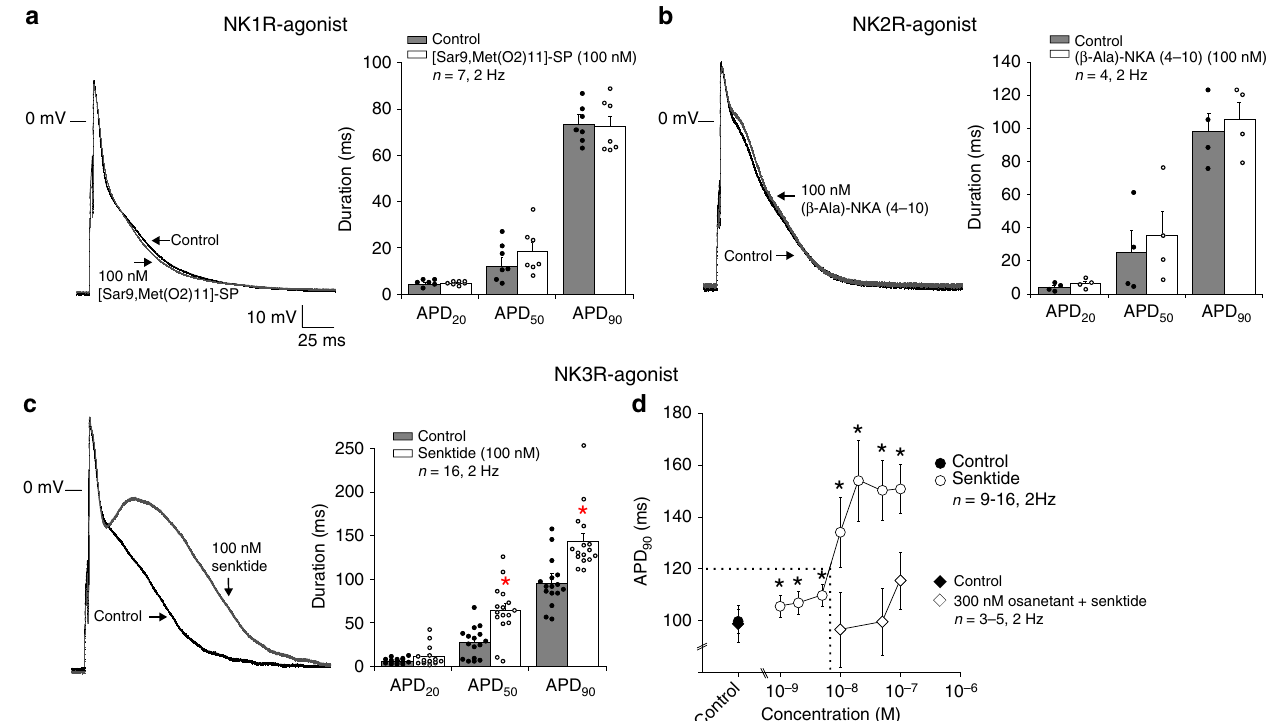
Fig. 4 Effects of different selective neurokinin receptor agonists on action potential duration. a APs elicited at 2 Hz from an atrial cardiomyocyte under control conditions (Control) and in the presence of 100 nM NK-1R agonist [Sar9,Met(O2)11]-SP. Bar graph shows average values for AP duration at 20, 50 and 90% of repolarization (APD 20 , APD 50 and APD 90 ) before (Control) and after application of 100 nM [Sar9,Met(O2)11]-SP ( N = 6, n = 7, paired t -test). b Atrial APs elicited at 2 Hz in Control and in the presence of the NK-2R agonist ( β -Ala)-NKA(4-10) (100 nM). Bar graph shows average values for APD 20 , APD 50 , and APD 90 before (Control) and after application of 100 nM ( β -Ala)-NKA(4-10) ( N = 3, n = 4, paired t -test). c Atrial APs elicited at 2 Hz in Control and in the presence of the NK-3R agonist Senktide (100 nM). Bar graph shows average values for APD 20 , APD 50 and APD 90 before (Control) and after application of 100 nM Senktide ( N = 7, n = 16, paired t -test). d Concentration-response curve for increase of APD induced by Senktide in the absence ( N = 13, n = 9 – 16, one-way RM ANOVA) and presence of 300 nM Osanetant ( N = 3, n = 3 – 5, two-way RM ANOVA). Dotted lines: concentration of Senktide at which APD 90 prolongation exceeded 20%. All values shown are mean ± SEM. * P <